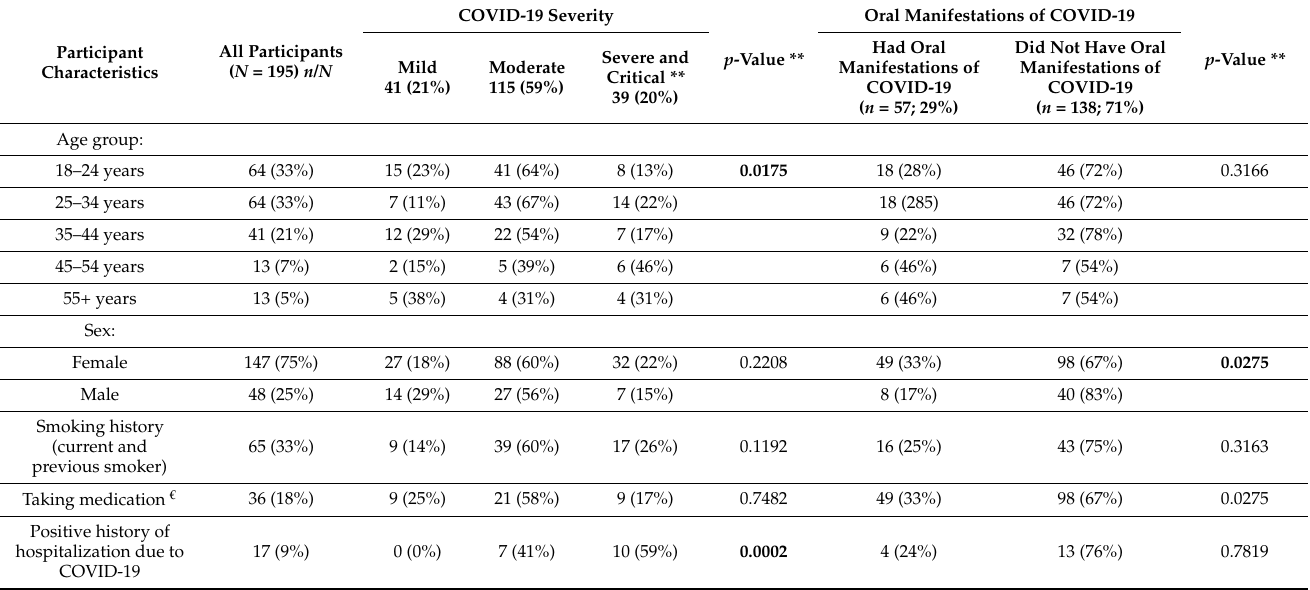
Table 1. Participant characteristics of COVID-19 with and without oral